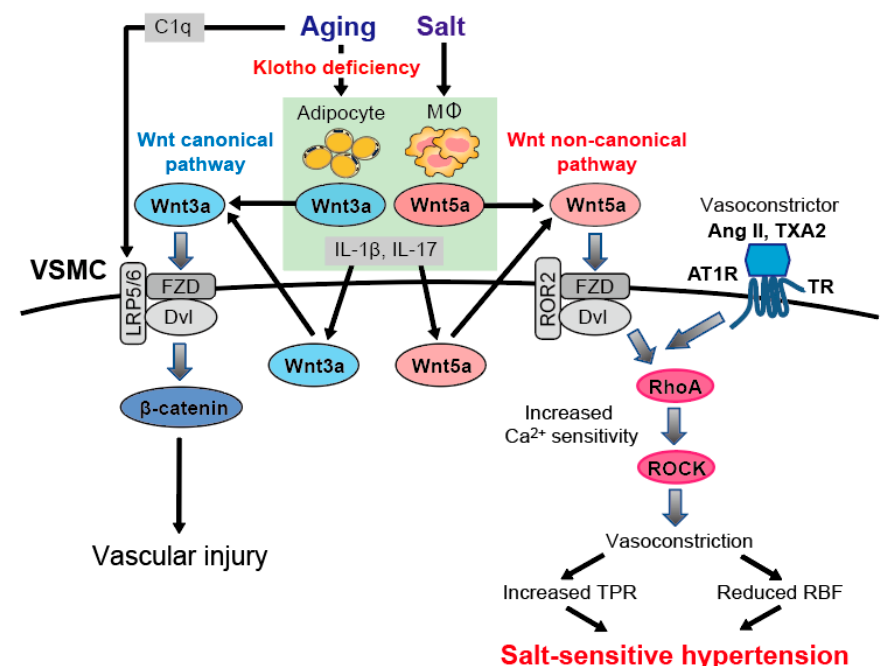
Figure 3. Potential mechanisms of aging-associated salt-sensitive hypertension and crosstalk between Wnt noncanonical pathway and angiotensin II (Ang II)-induced vasoconstrictive pathway. In aged mice with reduced serum klotho levels, high salt intake stimulates adipocytes and macrophages to produce cytokines such as IL-1 β and IL-17, which in turn stimulate vascular smooth muscle cells (VSMCs) to secrete Wnt3a and Wnt5a. Inflammatory cytokines also upregulate Wnt5a expression in macrophages and adipocytes via paracrine and autocrine signaling. Secreted Wnt5a activates the noncanonical Wnt-RhoA (PCP) pathway by binding to its receptor Frizzled (FZD) and the Wnt coreceptor tyrosine-protein kinase transmembrane receptor ROR2 in VSMCs. Activated RhoA/Rho- associated protein kinase (ROCK) increases the Ca 2+ sensitivity of VSMCs, leading to vasoconstriction. On the other hand, Ang II-induced RhoA/ROCK activation needs Wnt5a, and there is the crosstalk between Wnt noncanonical pathway induced- and Ang II-induced vasoconstriction in the process of RhoA activation. Consequently, total peripheral resistance (TPR) increases, and renal blood flow (RBF) decreases in the development of salt-sensitive hypertension. Aging-related salt-sensitive hypertension is thought to be related to increased vascular sensitivity to thromboxane A2 (TXA2) as well as Ang II. The canonical Wnt3a- β -catenin pathway is already enhanced with a normal salt diet, which might be a general feature of aging, regardless of klotho deficiency. Increased levels of complement C1q also activate the Wnt- β catenin pathway via cleavage of the Wnt coreceptors LRP5 and LRP6. High salt intake further increases Wnt3a- β -catenin signaling in the setting of klotho deficiency, leading to cardiac and vascular damage and arterial stiffness. Dvl, Dishevelled; LRP5/6, low-density lipoprotein receptor-related protein 5 and low-density lipoprotein receptor- related protein 6. We have modified this figure from our previous paper described below. This material is from: Wakako Kawarazaki and Toshiro Fujita, Kidney and epigenetic mechanisms of salt-sensitive hypertension, Nat Rev Nephrol, 2021, [Nature Springer] [37]. This indicates that the Wnt3a canonical pathway is upregulated with age, independent of serum klotho reduction. When fed a high-salt diet, aged mice and klotho heterozygous knockout mice, unlike WT mice, showed salt-sensitive hypertension, vascular RhoA acti- vation, and increased vasoconstriction. At the same time, in both aged mice and klotho heterozygous knockout mice, the high-salt diet increased the expression of Wnt3a and Wnt5a in the vasculature, and the Wnt3a β -catenin and Wnt5a-RhoA pathways were both enhanced. To determine which pathway is involved in the development of salt-sensitive hypertension, the β -catenin inhibitor ICG-001 and the Wnt inhibitor LGK974, which